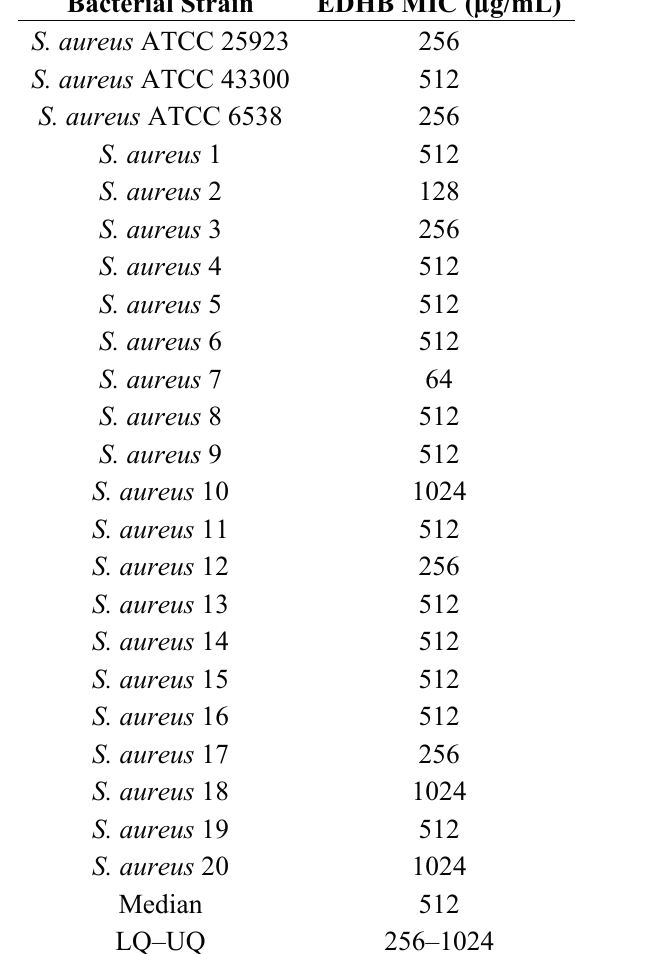
Table 2. MIC (µg/mL) of protocatechuic acid ethyl ester against S. aureus